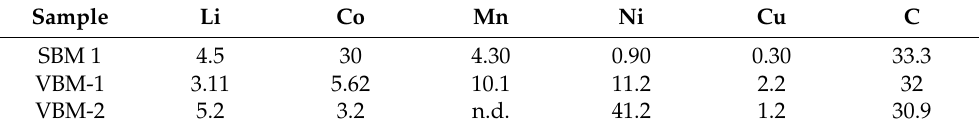
Table 1. Composition of metals and carbon of the black mass samples (weight percentage